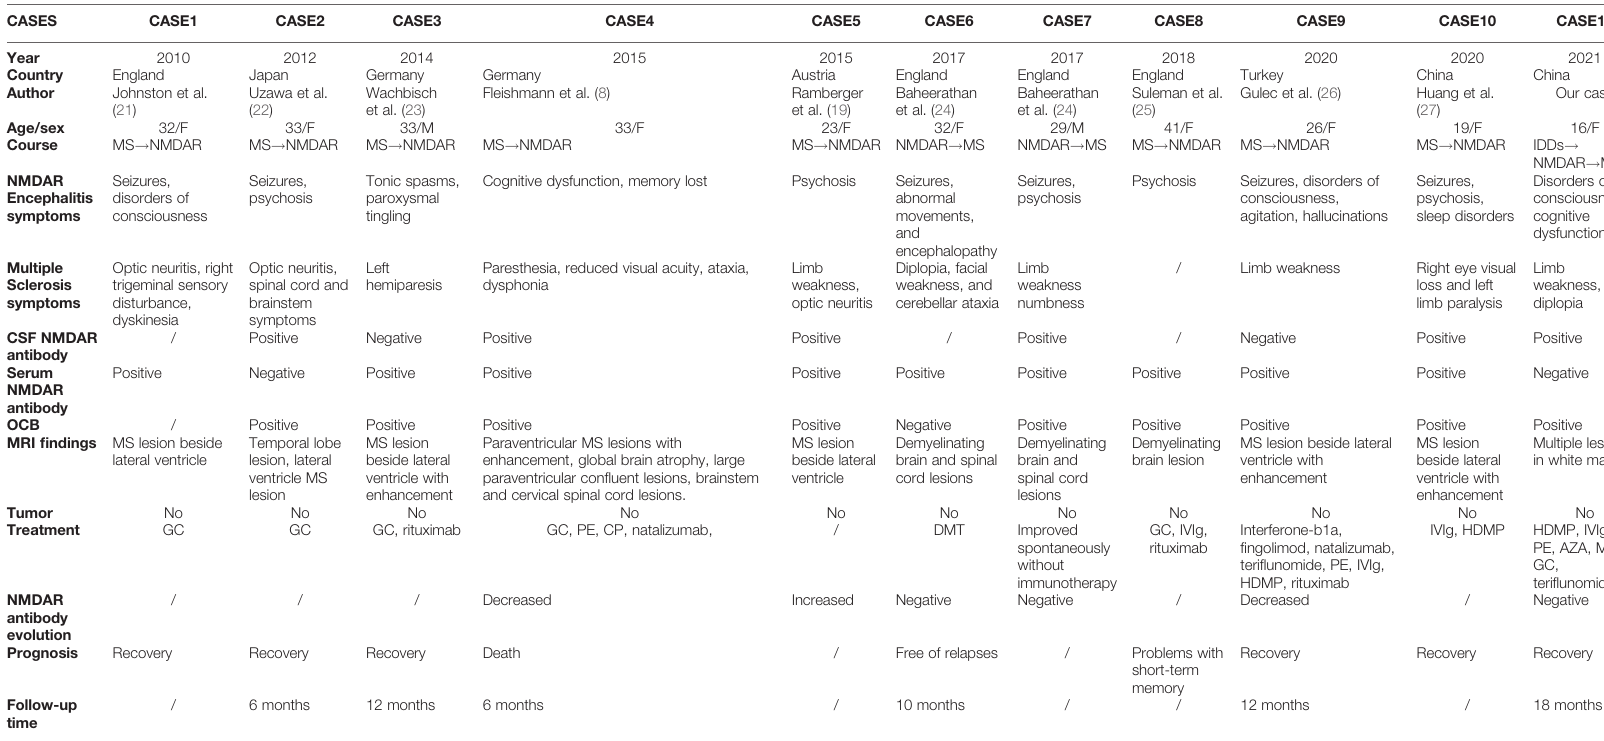
TABLE 2 | Previous case reports demonstrating the characteristics of patients with overlapping MS and anti-NMDAR encephalitis.